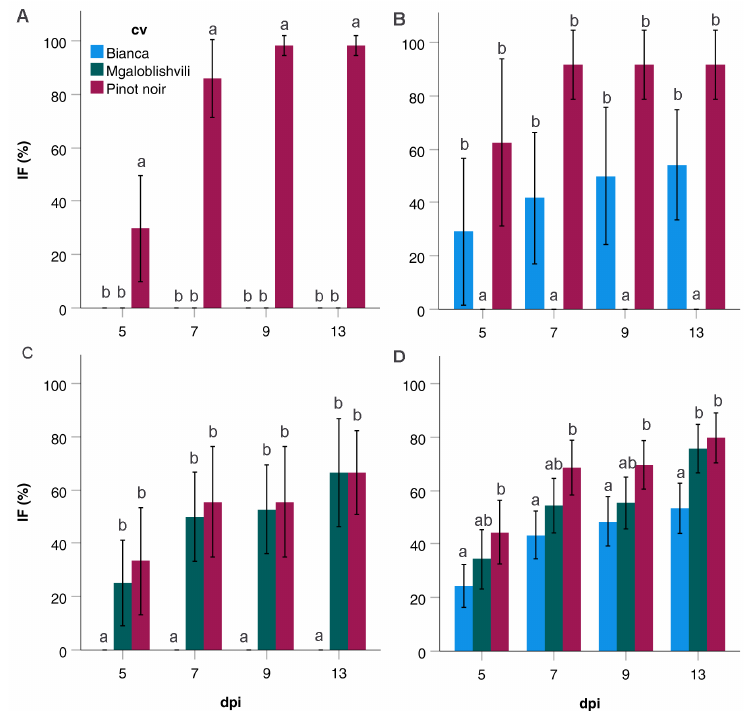
Figure 3. IF values (%) recorded on Bianca, Mgaloblishvili, and Pinot noir from 5 to 13 dpi by P. viticola isolates grouped in PC1 ( A ), PC2 ( B ), PC3 ( C ), and PC4 ( D ). Different letters within dpi indicate the existence of significant differences among IF values on the different cultivars ( p < 0.05). The PSA values obtained by the four PCs on the three cultivars are reported in Figure 4. Additionally, in this case, significant differences among cultivars were found in PC4. PC4 strains, in fact, caused significantly lower PSA ( p < 0.02) on B (at all time ‐ points) and on MG (from 7 to 13 dpi) than on PN (Figure 4D). Statistically analogous PSA values ( p > 0.07) were found among infecting PCs within cultivars at each dpi (Table 1).